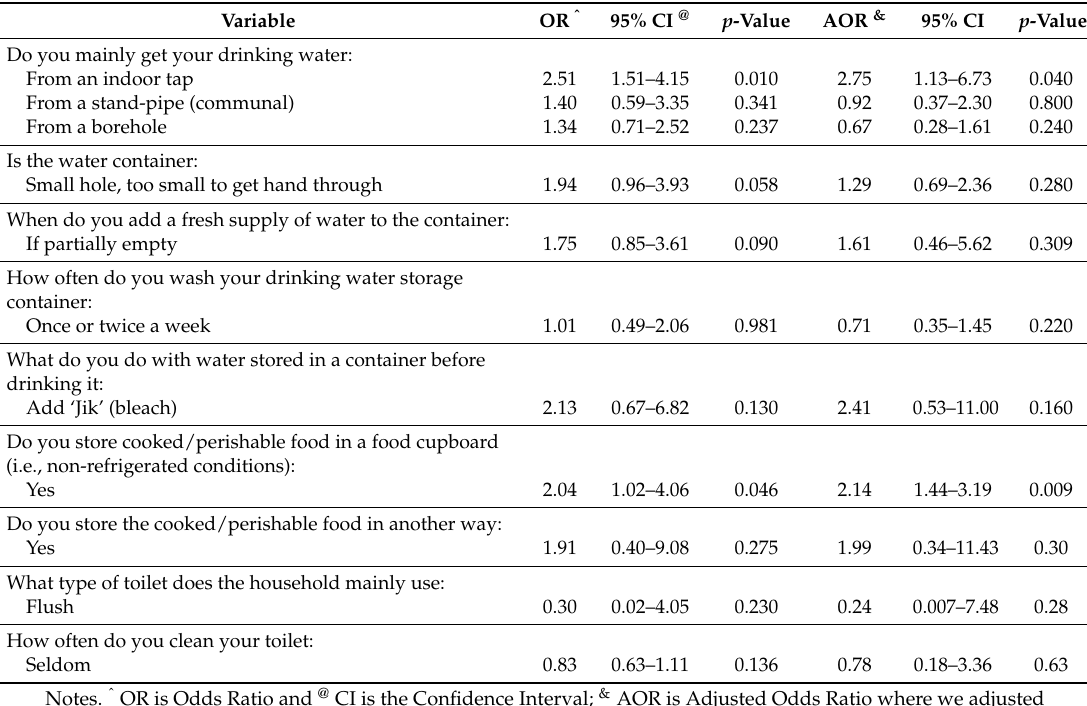
Table 3. Results of multivariate logistic regression for household risk factors in relation to household diarrhoea prevalence. Variable OR ˆ 95% CI @ p -Value AOR & 95% CI p